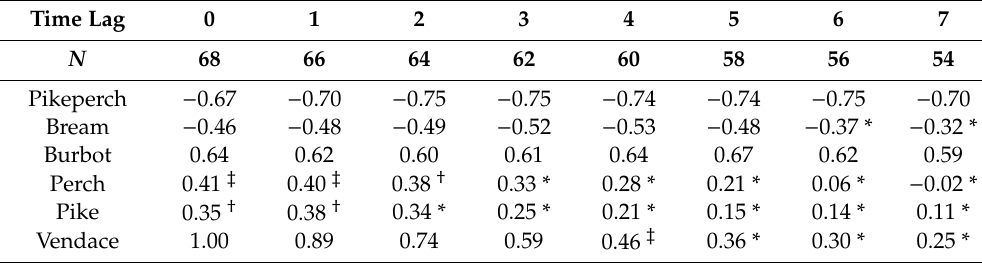
Table 4. Spearman correlations between vendace catches and catches of other fish species in the current and the preceding seven-year period (time lag of 0–7